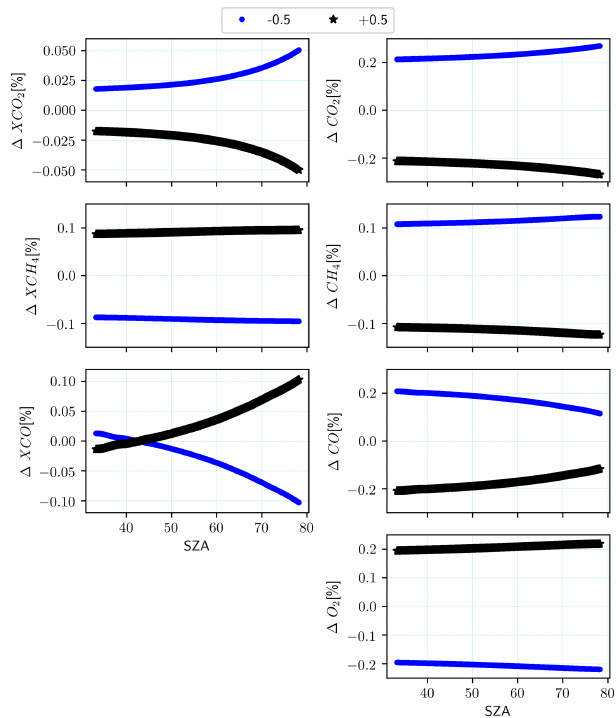
Figure 1. Variation in the relative difference for dry-air gas and total column gas amounts as a function of solar zenith angle (SZA), for changes in the original ILS of ± 0 . 5% of the original ILS parame- ters for COCCON’s reference unit SN37 on 31 May 2021 at Karl- sruhe, Germany, for carbon dioxide, methane and carbon monoxide, respectively, and the total column amount for